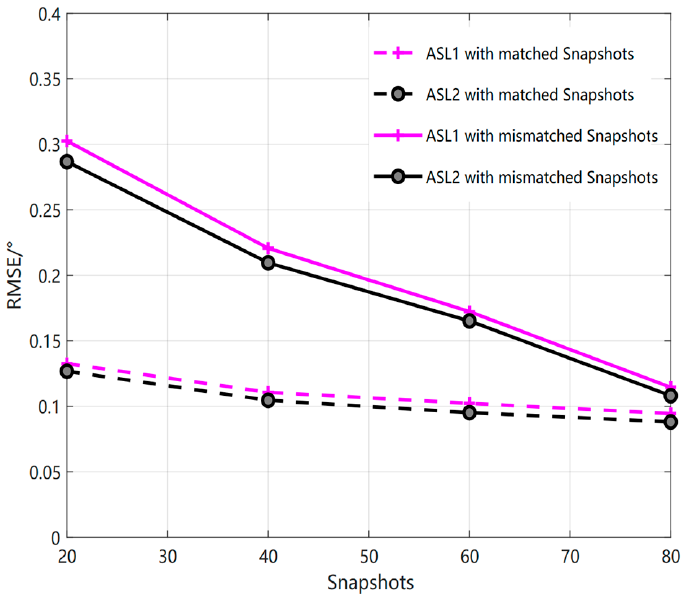
Figure 3. Relationship curve between RMSE and Snapshots (The real line is mismatched, and the imaginary line is matched.).